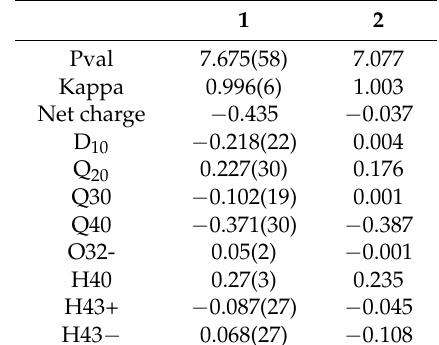
Table 5. Monopole populations (Pval), radial parameters ( κ ), multipolar coefficients (dipole (D), quadrupoles (Q), octupoles (O), and hexadecapoles (H)), and atomic charges for cobalt from X-ray data ( 1 ), and from theoretical densities ( 2 ). Some coefficients are zero because the Co site corresponds to the Wyckoff position 3 and some multipolar functions do not have C 3 symmetry.